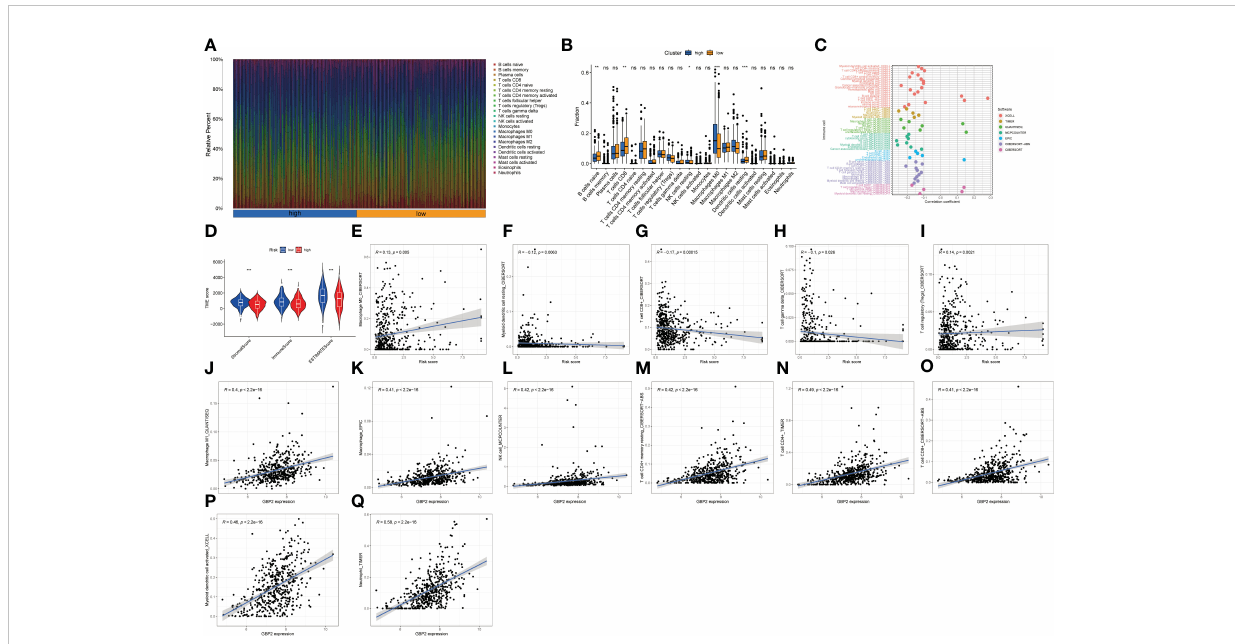
FIGURE 6 The proportion of immune cells, TME score, and in fi ltrative immune cells based on the LNPRS for the TCGA cohort. (A, B) The proportion of immune cells of patients with different LNPRS (ns ≥ 0.05, *< 0.05, **< 0.01, ***< 0.001). (C) The correlation analysis of the immune cells with LNPRS by 7 calculation methods. (D) The variance analysis of stromal score, immune score, and ESTIMATE score in the different risk groups. (E – Q) The correlation analysis of different immune cells and GBP2 gene expression.